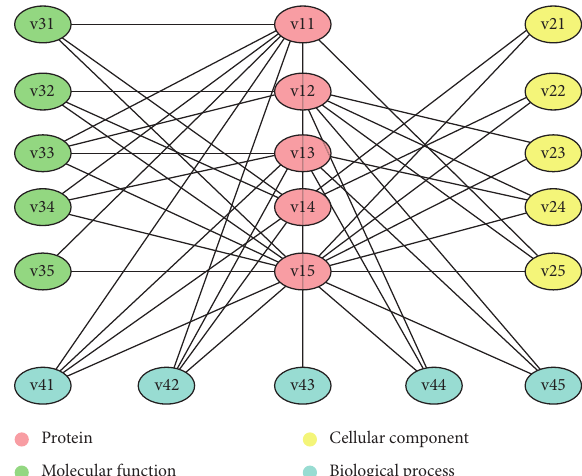
Figure 2: Illustration of three bipartite graph.